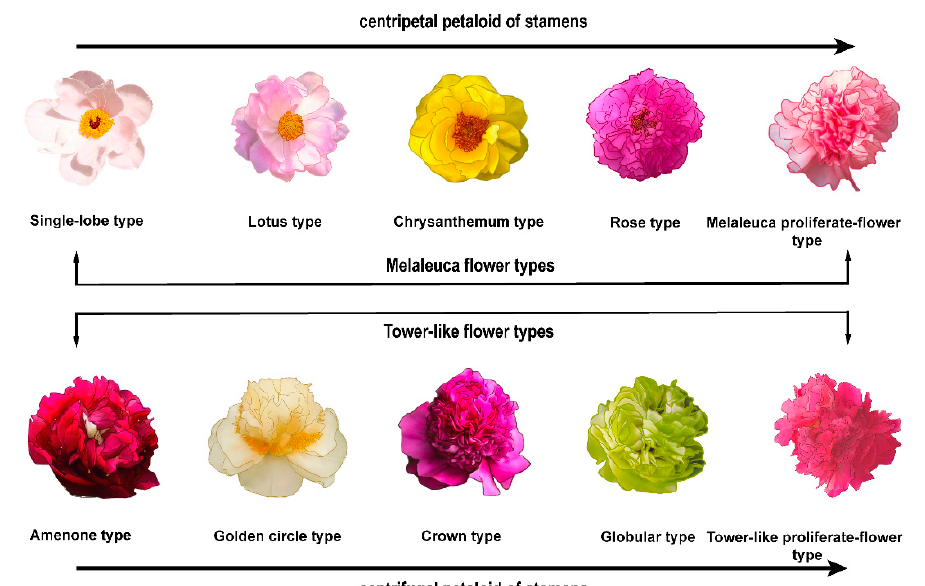
Figure 1. Flower types of all 10 tree peony cultivars. From left to right, from top to bottom were P . ostii cv. ‘ Feng Dan ’ (single-lobe type), P . suffruticosa cv. ‘ Da Jin Fen ’ (lotus type), P. × lemoinei ‘ High Noon ’ (chrysanthemum type), P . suffruticosa cv. ‘ Da Zong Zi ’ (rose type), P . suffruticosa cv. ‘ Cao Zhou Hong ’ (melaleuca proliferate-flower type), P . suffruticosa cv. ‘ Greendragon sleeping pool ’ (anemone type), P . suffruticosa cv. ‘ Yao Huang ’ (golden circle type), P . suffruticosa cv. ‘ Shou An Hong ’ (crown type), P . suffruticosa cv. ‘ Dou Lv ’ (globular type) and P . suffruticosa cv. ‘ Guan Qun Fang ’ (tower-like proliferate-flower type).